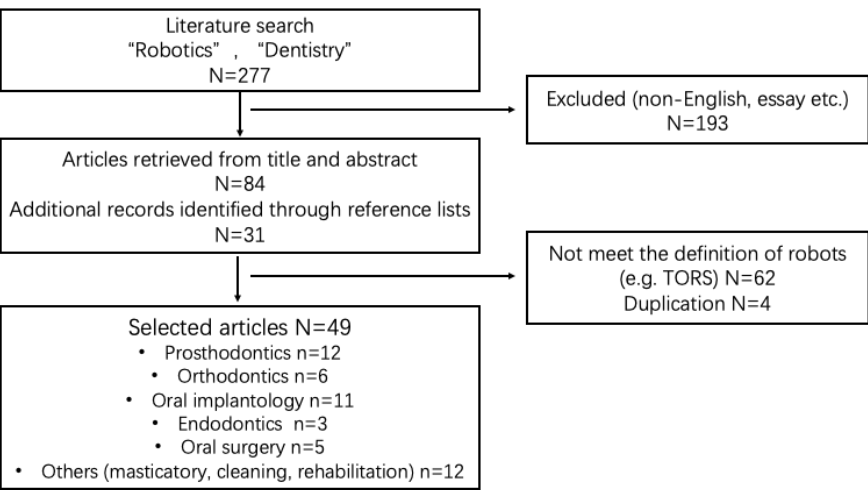
Figure 1. Flow chat for screening and selection of articles.